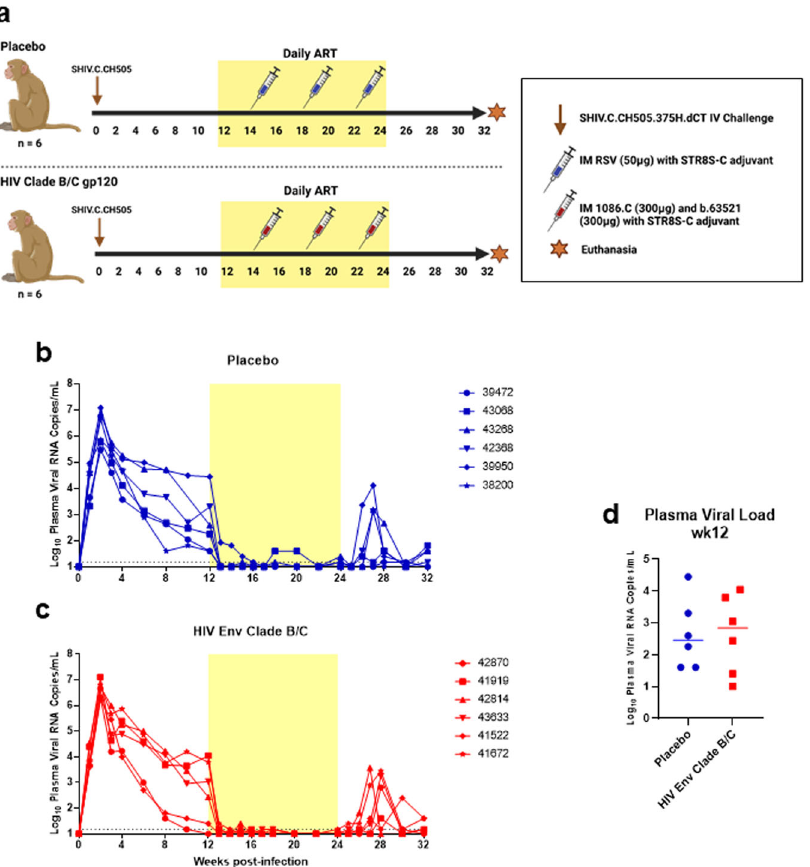
Fig. 1 Infection, treatment, and immunization schedule for study of vaccine-elicited responses in SHIV-infected, ART-treated female monkeys to reduce MTCT. a Study design schematic. Twelve female RMs were infected with SHIV.C.CH505 (brown arrow), started on a daily ART regimen at 12 wpi (yellow box). Six RMs received either a placebo vaccine (blue syringes) or a HIV Env combined clade B/C gp120 vaccine (red syringes). ART was discontinued at 24 wpi, and RMs were monitored for an additional 8 weeks. Plasma viral RNA kinetics through 32 wpi for placebo vaccinated ( b ) and HIV Env Clade B/C gp120 ( c ) vaccinated RMs. Plasma vRNA load at 12 wpi, prior to ART start, in placebo (blue) and HIV Env (red) vaccinated RMs ( d ). Medians are represented by the horizontal